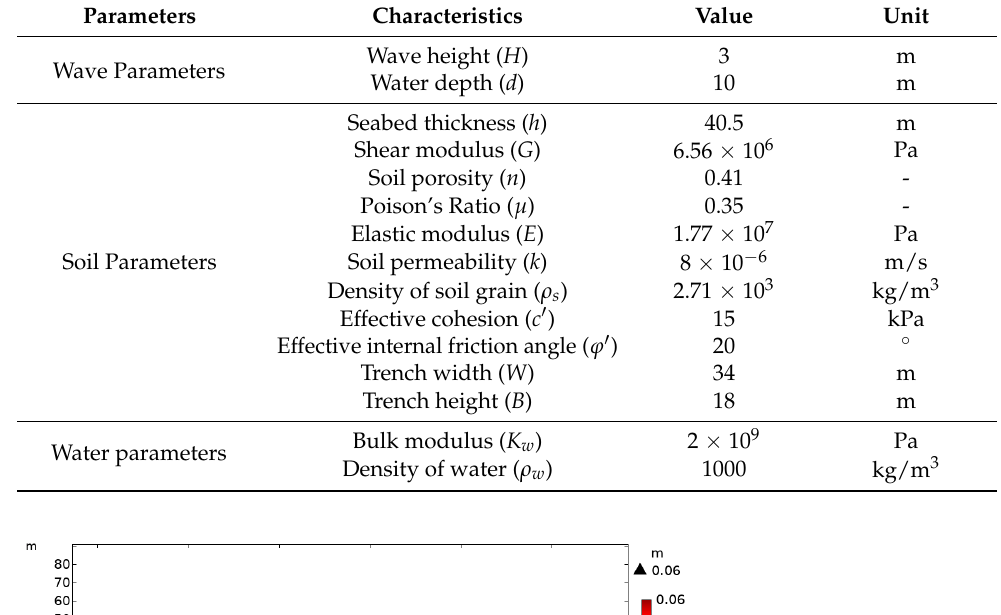
Table 1. Input parameters for parametric study.